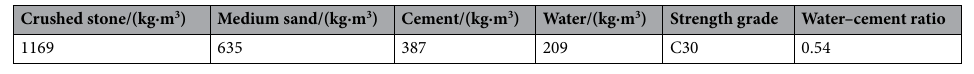
Crushed stone/(kg·m 3